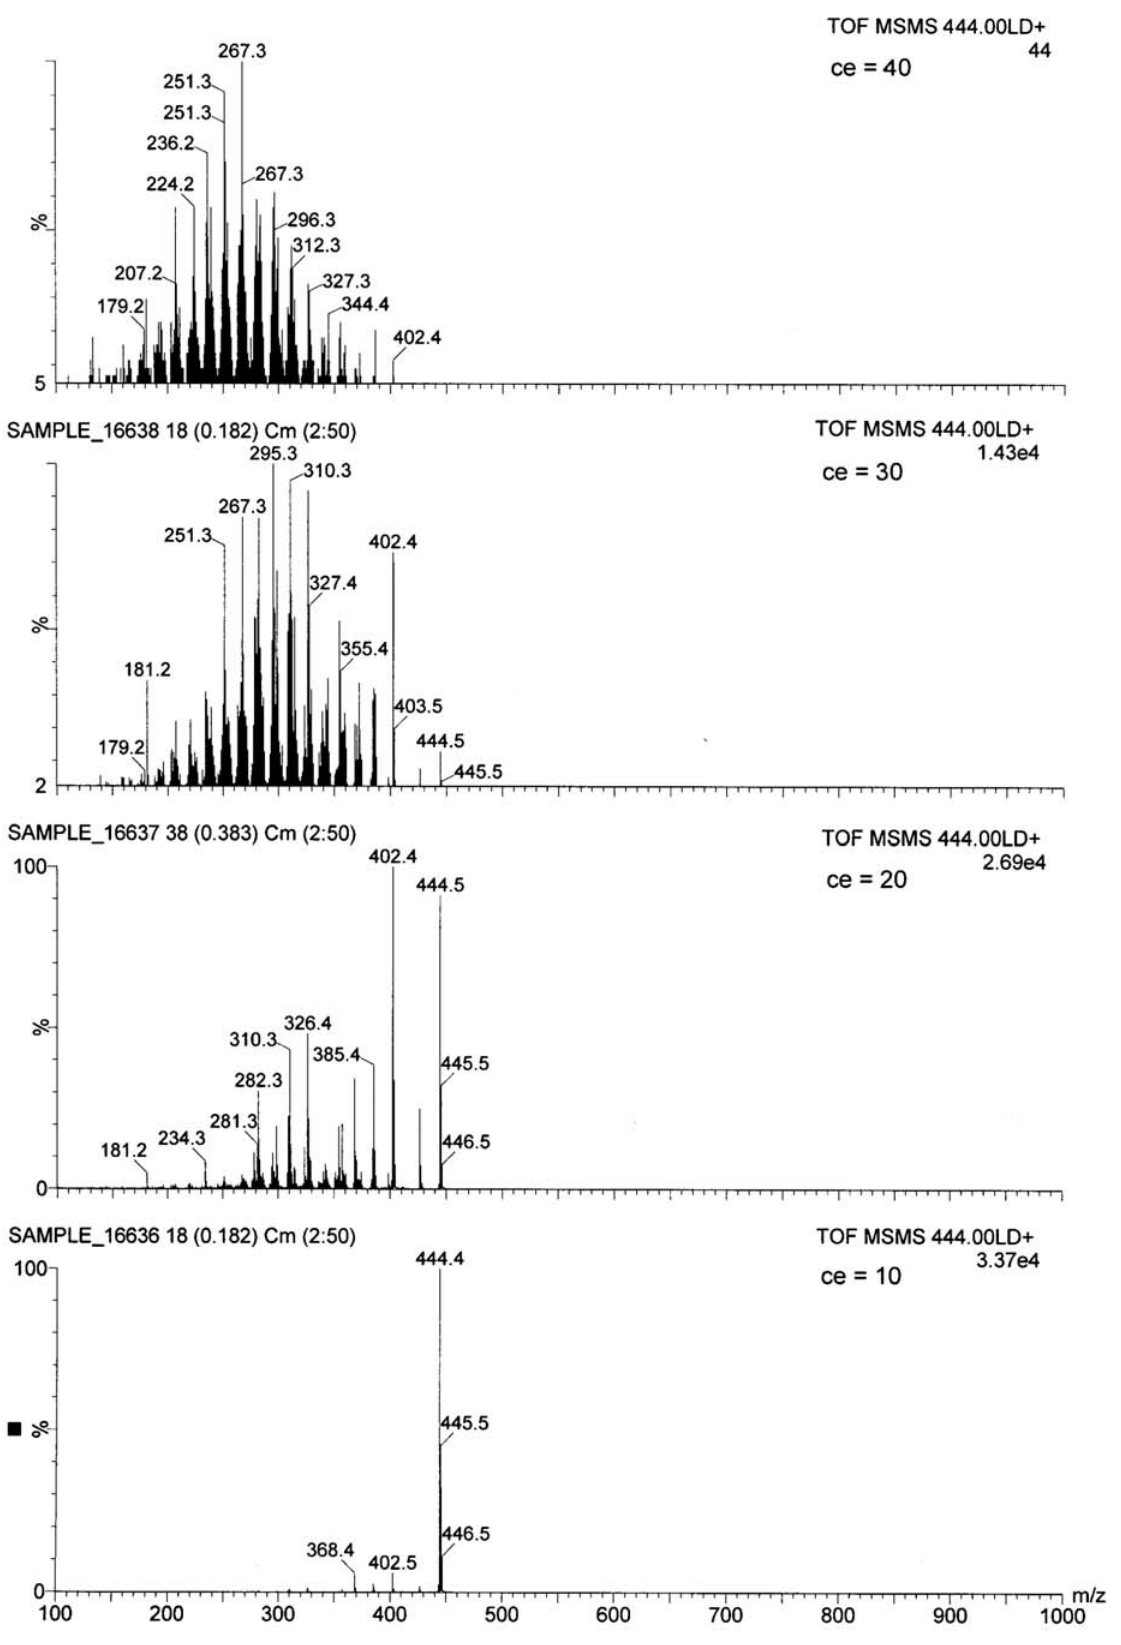
Fig. 3. MALDI TOF MS/MS spectra of precursor ion [ M+H ] + i.e. protonated 10- n -propylthiocolchicine 3 ( m/z 444) at CE = 10, 20, 30 and 40